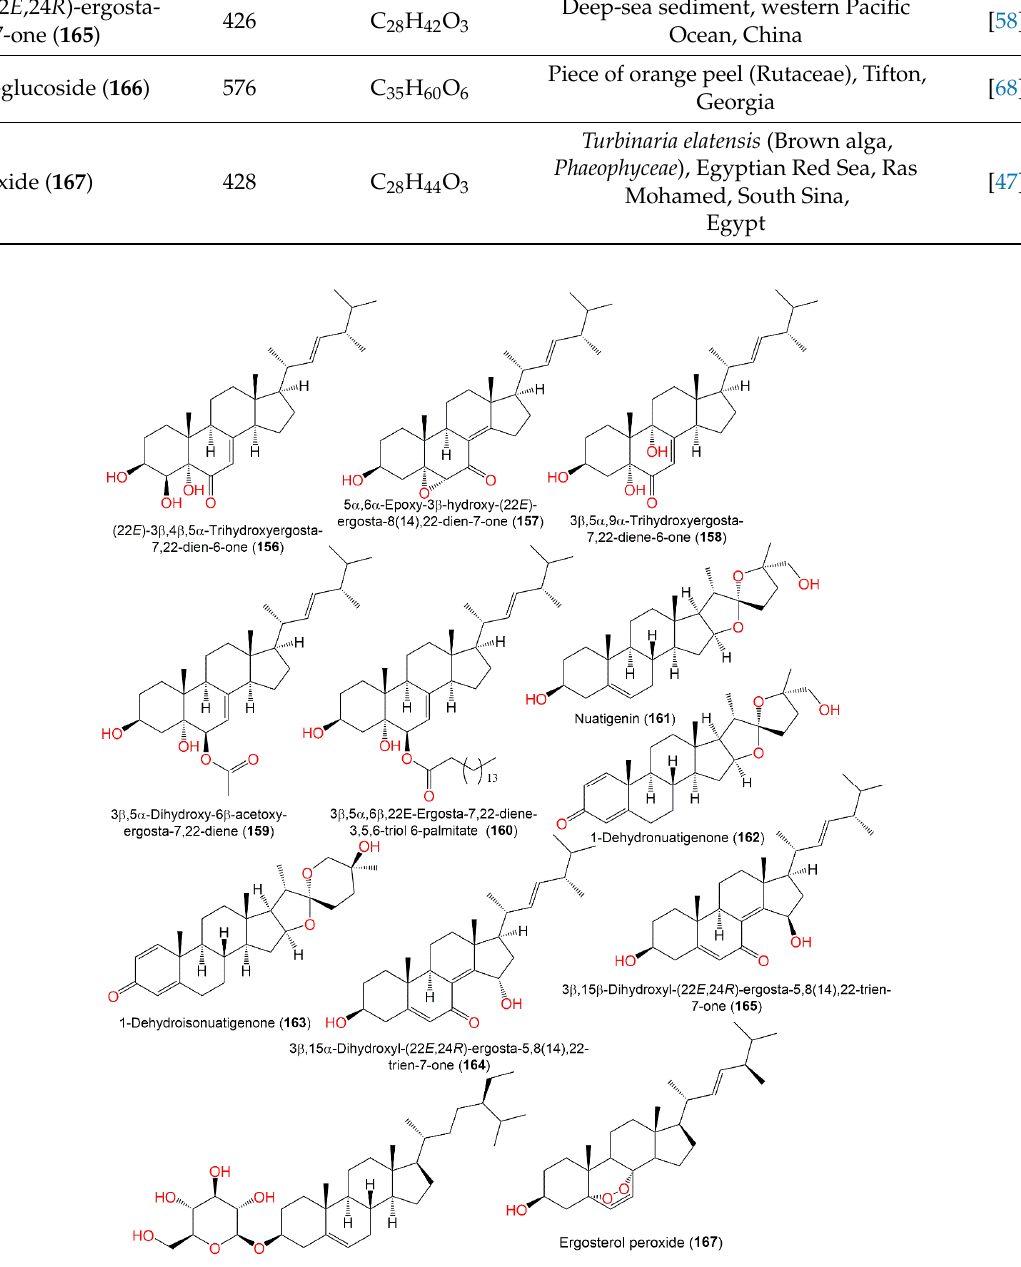
Figure 17. Structures of sterols ( 156 – 167 ).